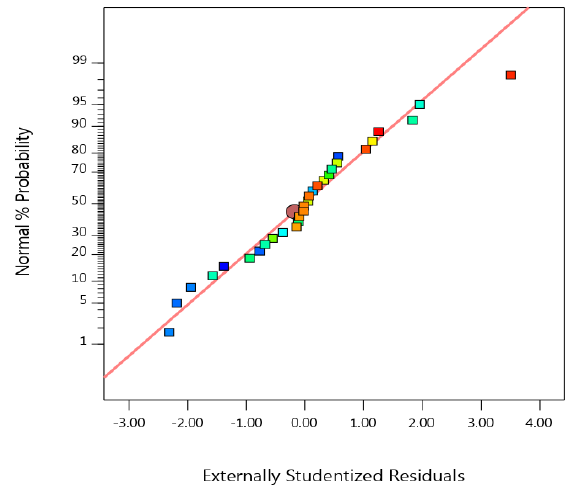
Figure 6. Normal probability plots of